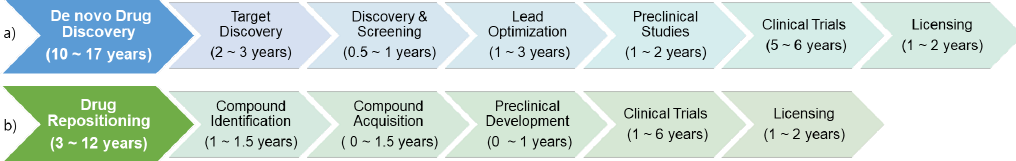
Figure 1. A comparison of traditional de novo drug discovery versus drug repositioning. ( a ) De novo drug discovery. ( b ) Drug repositioning. Traditional de novo drug synthesis ( a ) takes longer to get approved than drug repositioning ( b ). Table 1. Repositioned drug list. Drug Original Indication New Indication Aspirin Inflammation, analgesia Antiplatelet, colorectal cancer Parkinson disease, Atomoxetine ADHD depressive disorder Amantadine